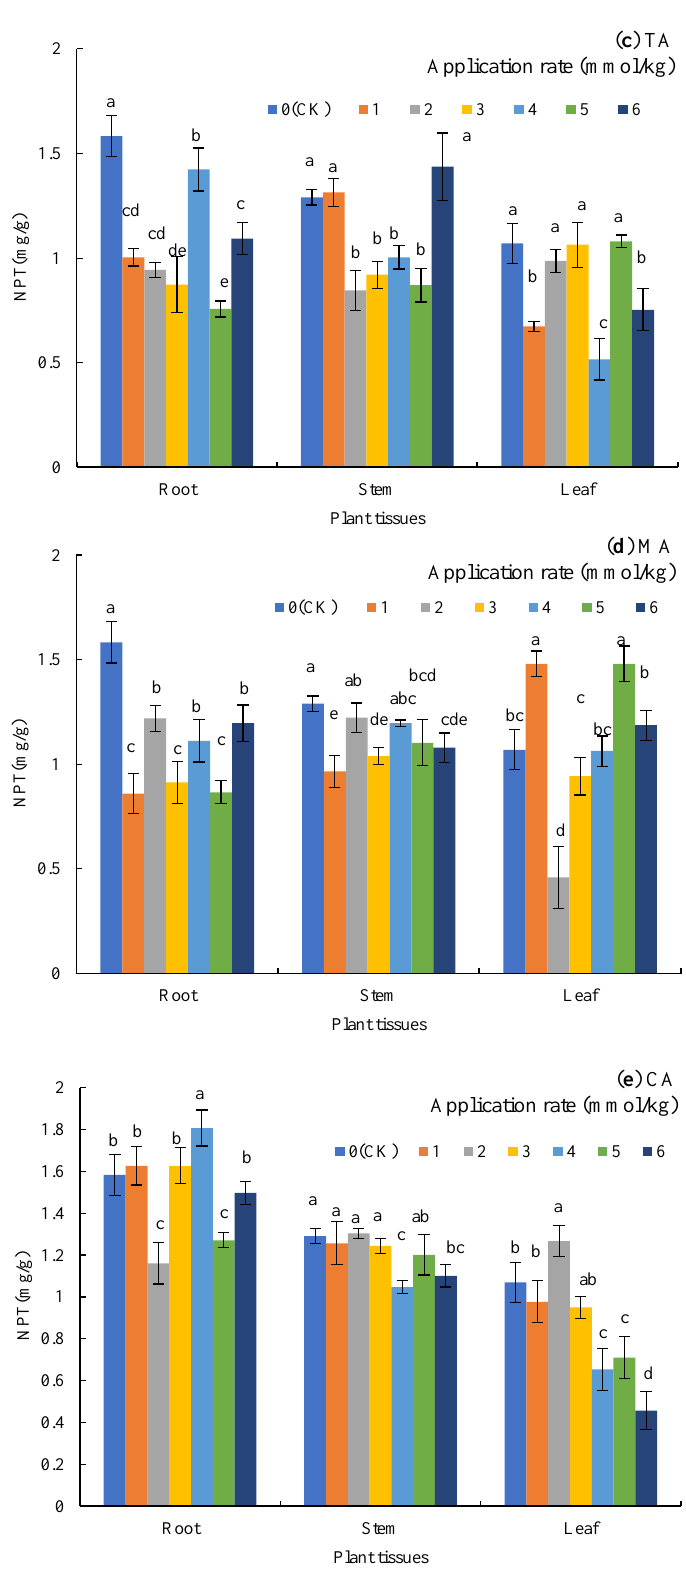
Figure 3. Nonprotein sulfhydryl (NPT) in the plant tissues under LMWOA treatments and the CK; ( a ) oxalic acid (OA), ( b ) acetic acid (AA), ( c ) tartaric acid (TA), ( d ) malic acid (MA), and ( e ) citric acid (CA). Different lowercase letters show significant differences for p < 0.05.